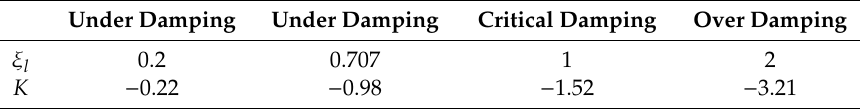
Table 4. The parameter K derived from di ff erent damping ratios ξ l . Under Damping Under Damping Critical Damping Over